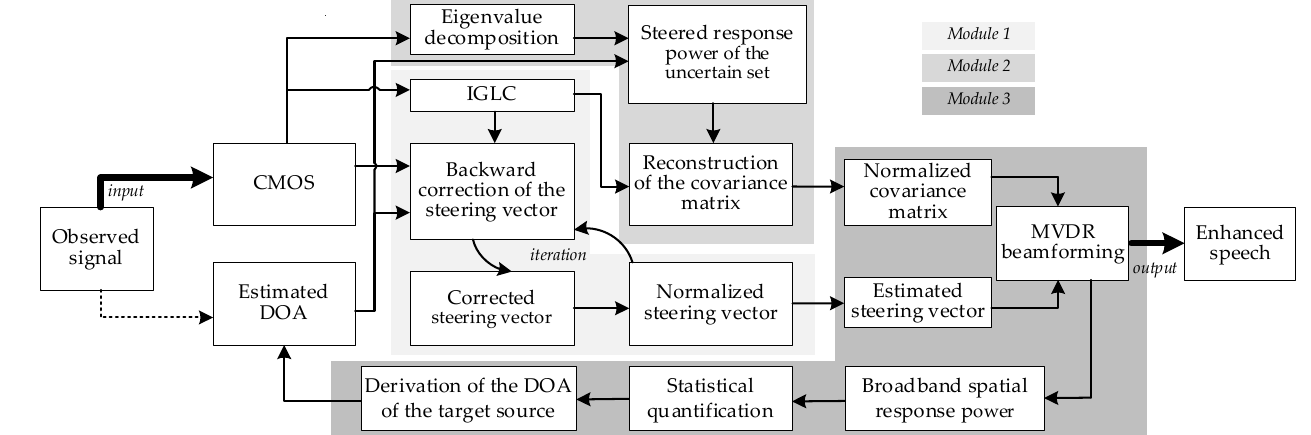
Figure 1. The framework of the proposed method.